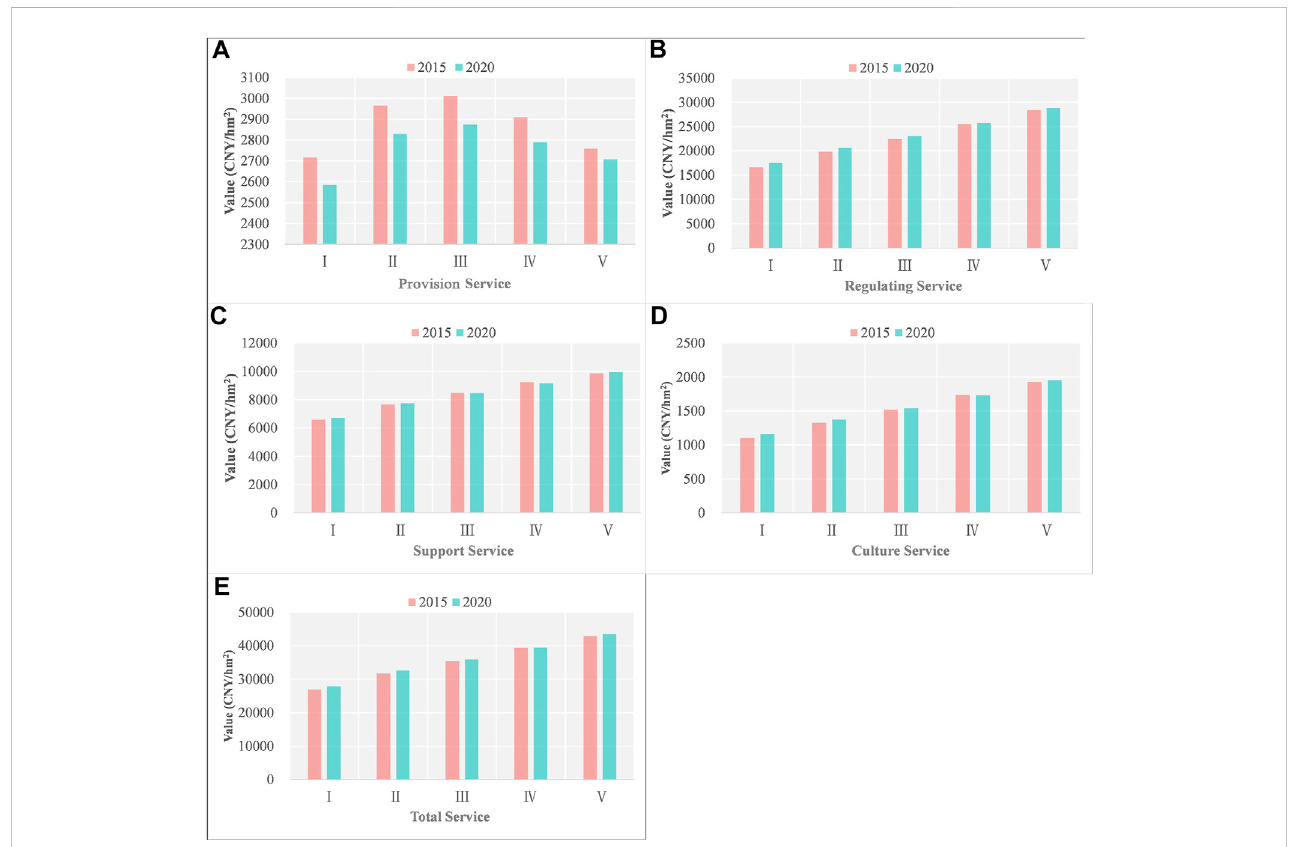
FIGURE 6 DistributionofthevalueofdifferentecosystemservicesatdifferentTPIlevels.Inthiscombinationdiagram: (A) thispanelisthevalueofprovisionservices; (B) this panel is the value of regulation services; (C) this panel is the value of support services; (D) this panel is the value of culture services; and (E) this panel is the value of total